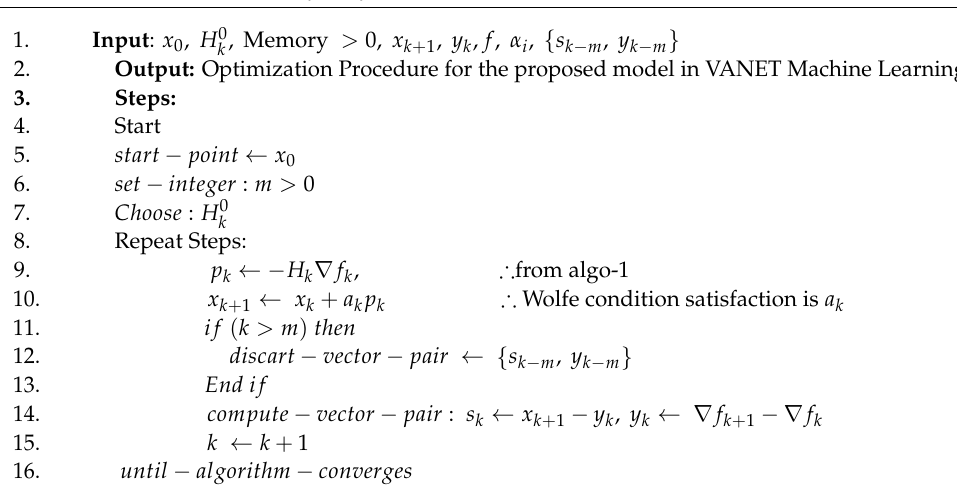
Algorithm 2: Limited-memory Brayden–Fletcher–Goldfarb–Shannon